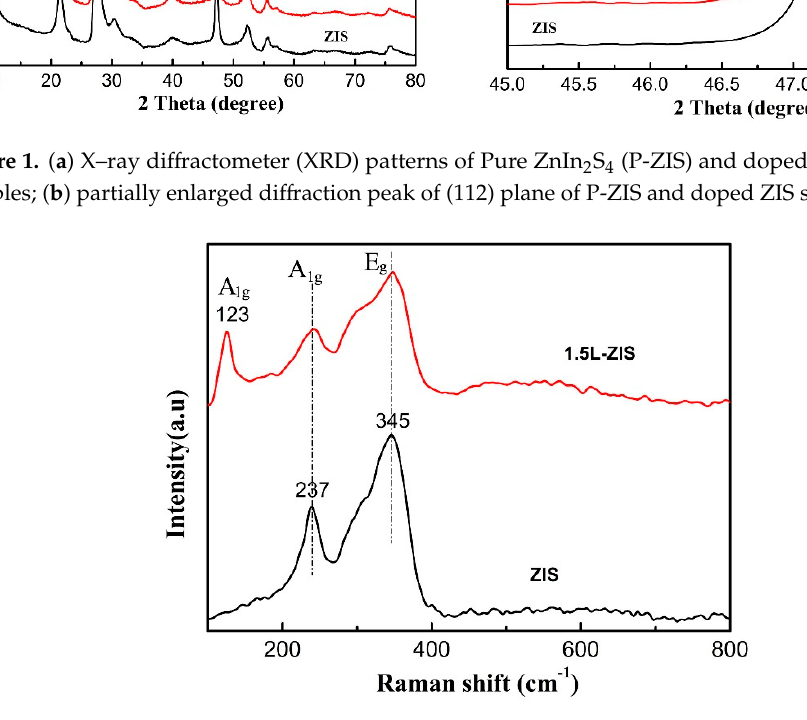
Figure 2. Raman spectra of P-ZIS and 1.5 at%-doped ZnIn 2 S 4 (1.5L-ZIS) samples.